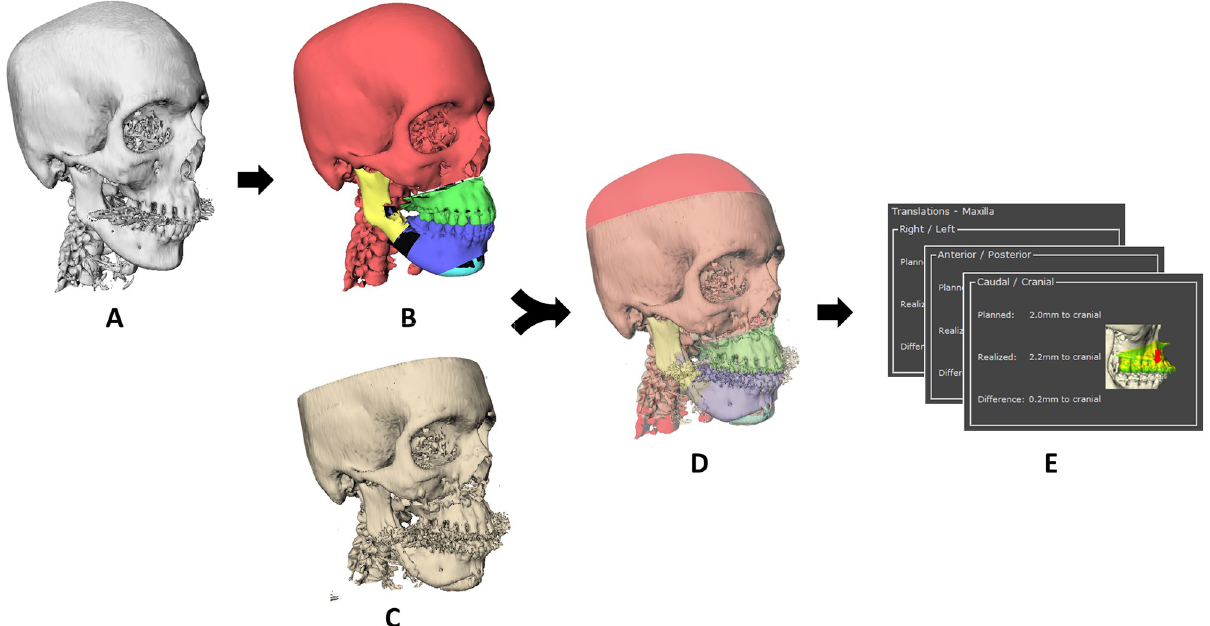
Fig 1. Global overview of the workflow of OrthoGnathicAnalyser 2.0. A) Preoperative (CB)CT scan of the patient. B) Virtually planned 3D models. C) Postoperative (CB)CT scan. The postoperative (CB)CT scan is voxel-based matched to the preoperative (CB)CT scan. Individual segments of the preoperative (CB)CT scan are matched to the postoperative (CB)CT scan. D) Overlap of the postoperative (CB)CT scan and planned STL models. E) planned, realized and difference of the three translation and three rotation parameters are computed for the maxilla, mandible, chin, left and right